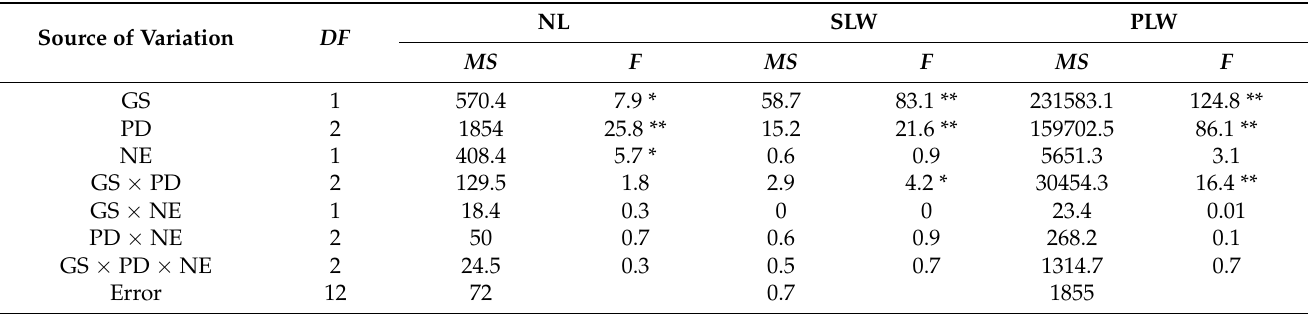
Table 1. Analysis of variance of three factors of C. bilineata tsingtauica larval growth in spring sowing net